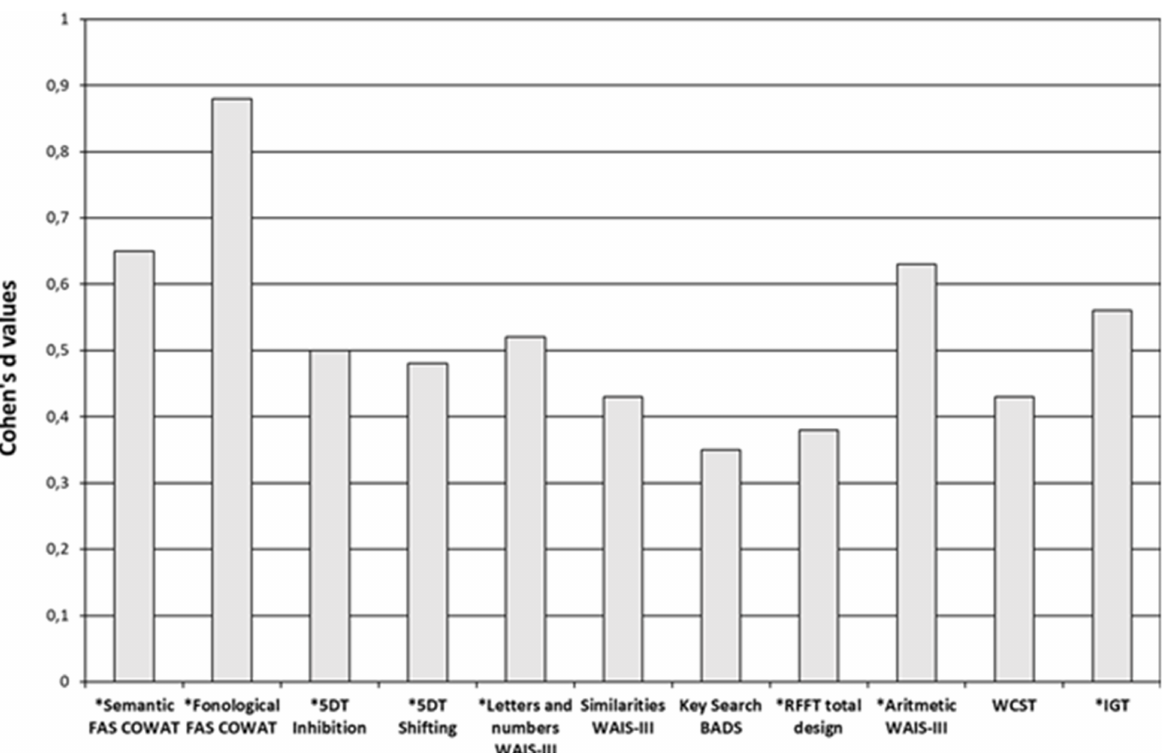
Fig 1. Cohen’s d values for group comparison of the dependent variables (the order of the tests in the figure follows their administration sequence).